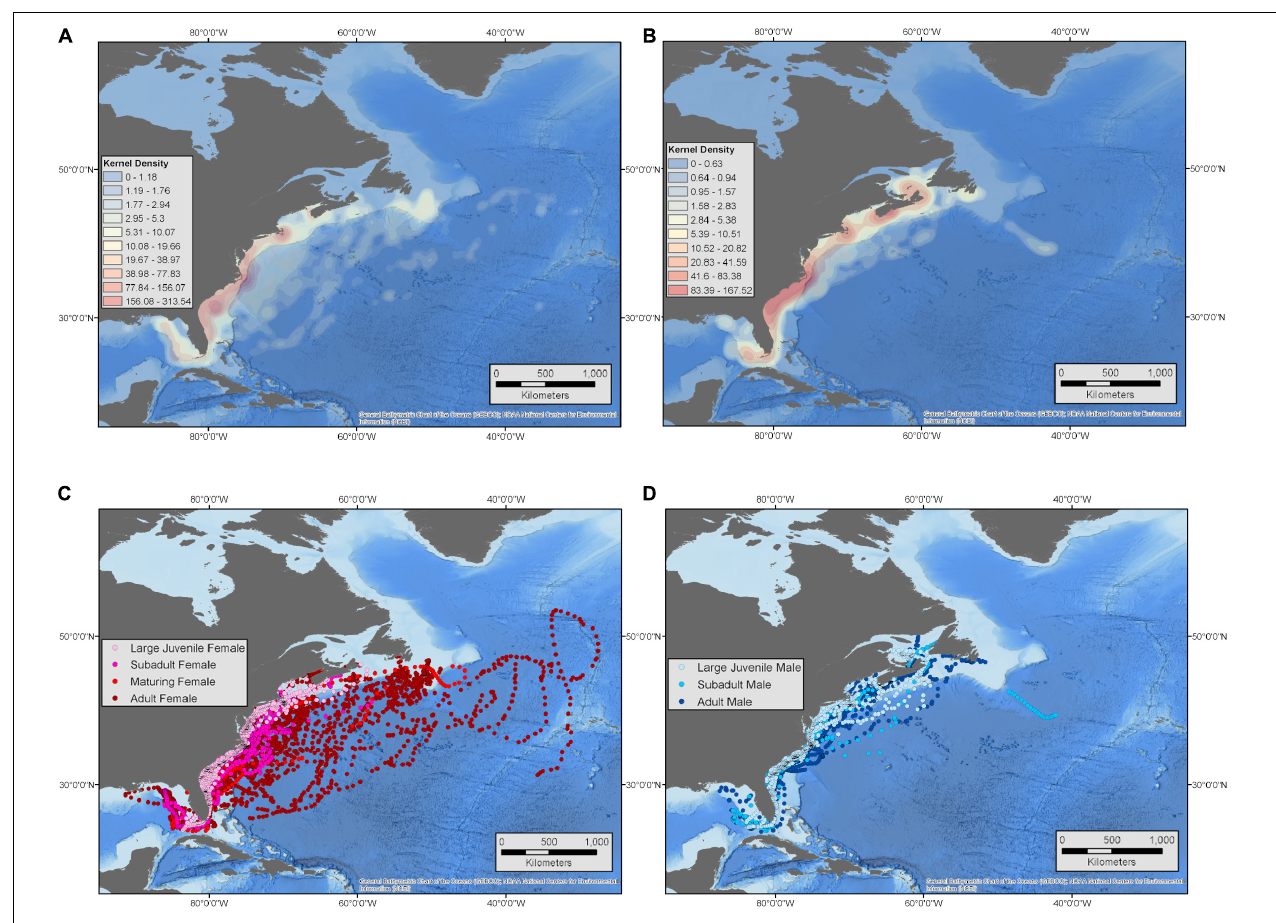
FIGURE 4 | Kernel density plots generated using pooled locations from all female white sharks (A) and all male white sharks (B) . Underlying daily hSSM-derived locations for each life stage for female (C) and male (D) sharks with color scaled by life stage from large juvenile to